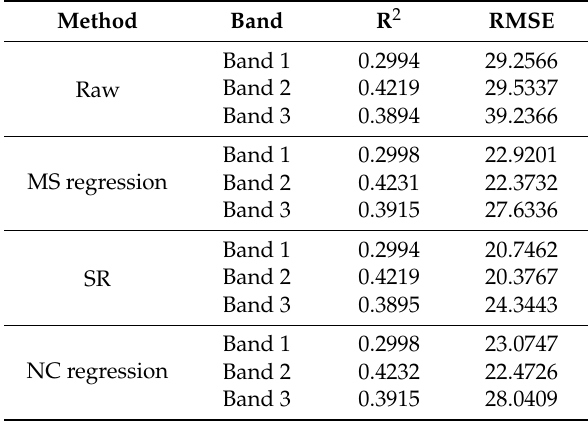
Table 2. Statistical results (R 2 and RMSE) of linear regression normalization.